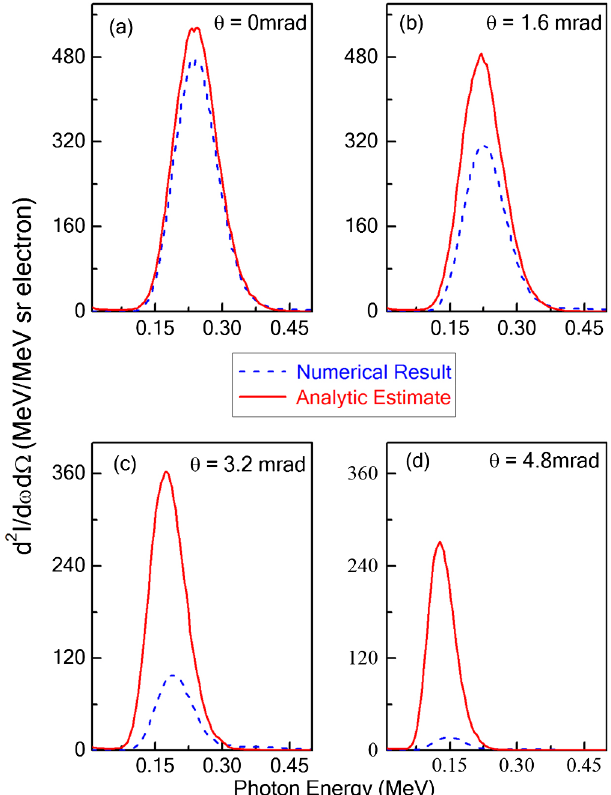
FIG. 3. Radiated energy density calculated numerically (dashed-blue line) and estimated analytically using Eq. (3) (red line). The radiation is calculated at four different observa- tion angles: (cid:4) ¼ 0 , 1.6, 3.2, and 4.8 mrad; measured with respect to the electron beam propagation axis and in the plane containing the polarization-propagation axis of the scattering laser pulse. For the smallest angle, (cid:4) , the radiation yield calculated analyti- cally is in a reasonable agreement with our model. The agree- ment gets worse as the observation angle, (cid:4) , is increased.